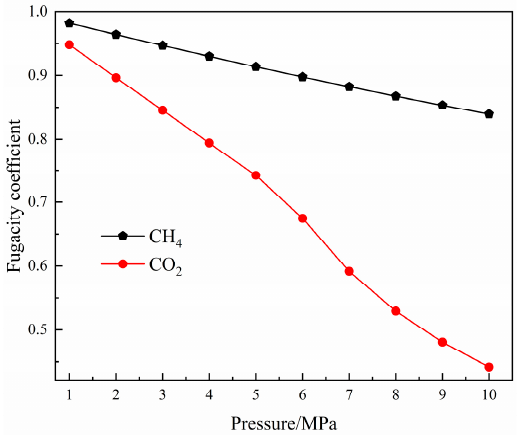
Figure 2. The relationship between the fugacity coefficient of gas and its pressure.